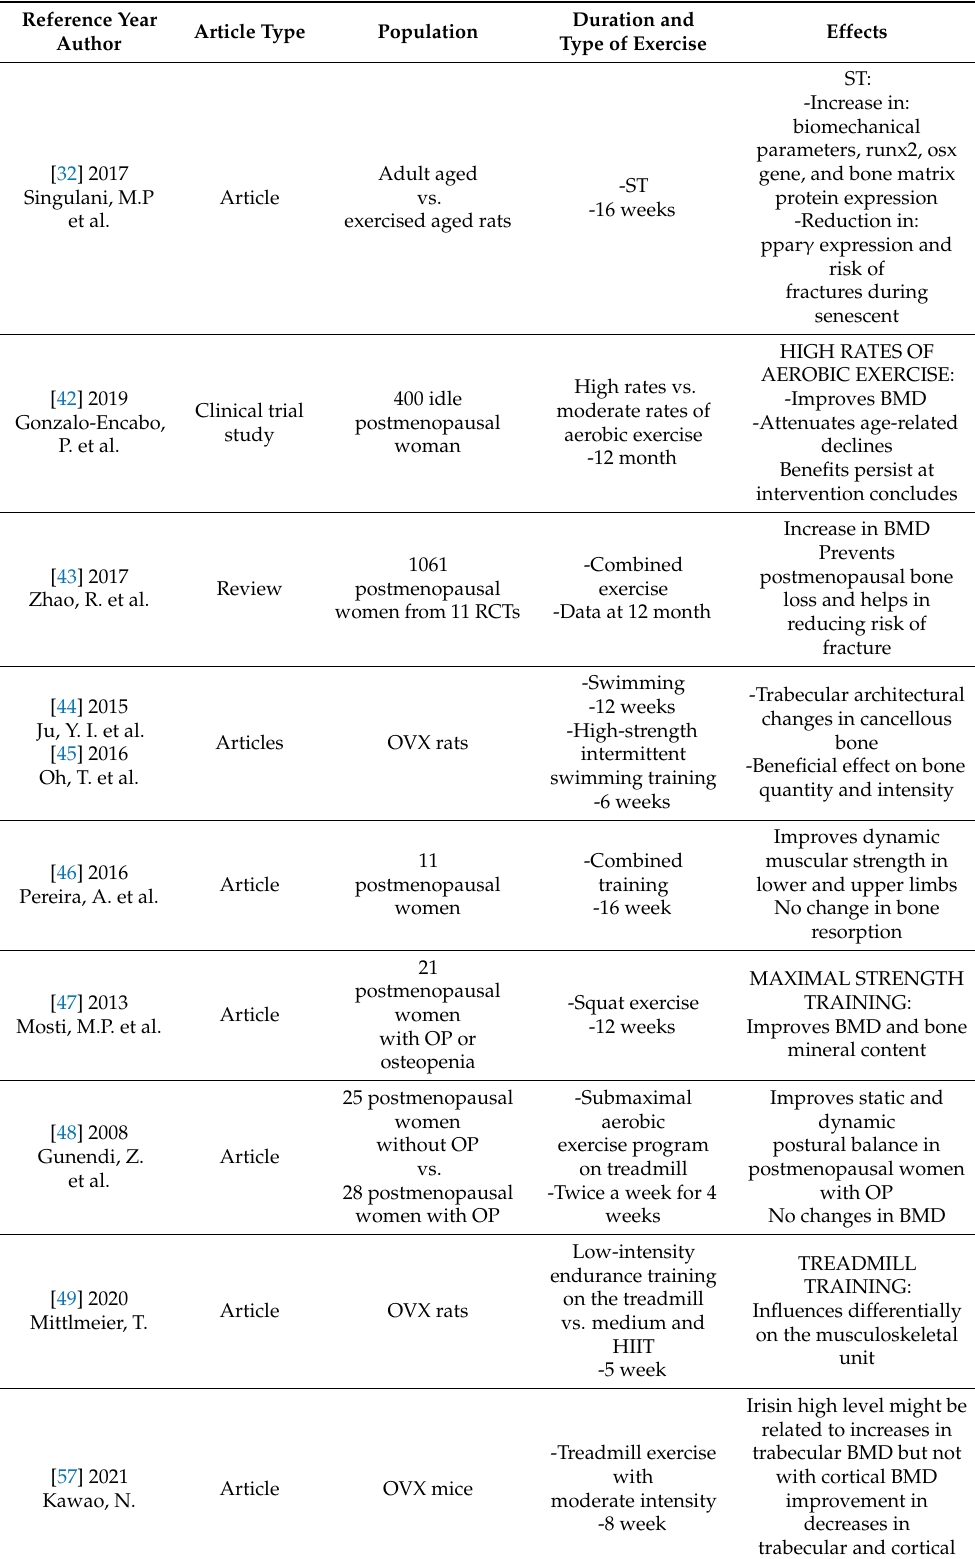
Table 3. Impact of different exercises on bone metabolism in osteoporosis